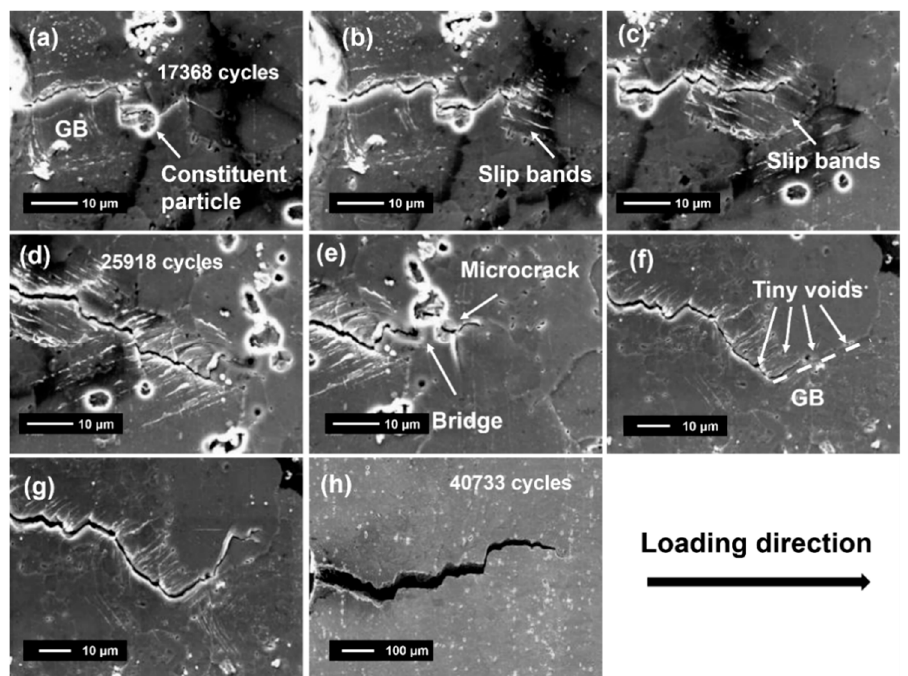
Figure 13. SEM micrographs for the evolution of crack growth of High Fe alloy ( a ) after 17,368 loading cycles, ( b , c ) slip bands generated, ( d , e ) after 17,368 loading cycles, ( f ) the interaction between the crack and the small-sized constituent particles, ( f ) the crack deflection, and ( g , h ) morphology of the crack propagating rapidly.